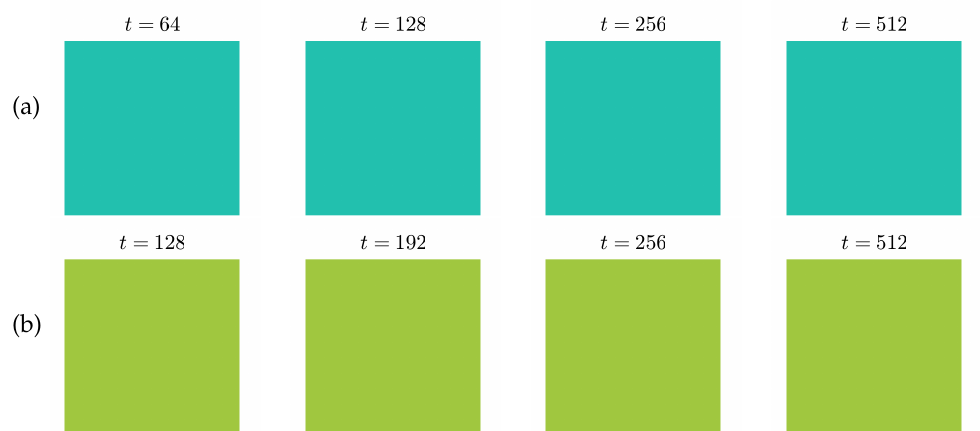
Figure 3. Evolution of φ ( x , y , t ) using the operator splitting method in [17] with ( a ) ¯ φ = 0.02 and ( b ) 0.2. Here, (cid:101) = 0.2, ∆ x = ∆ y = 1 , and ∆ t = 2 are used. The yellow, green, and blue regions show 3 φ = 0.5, 0, and − 0.5,